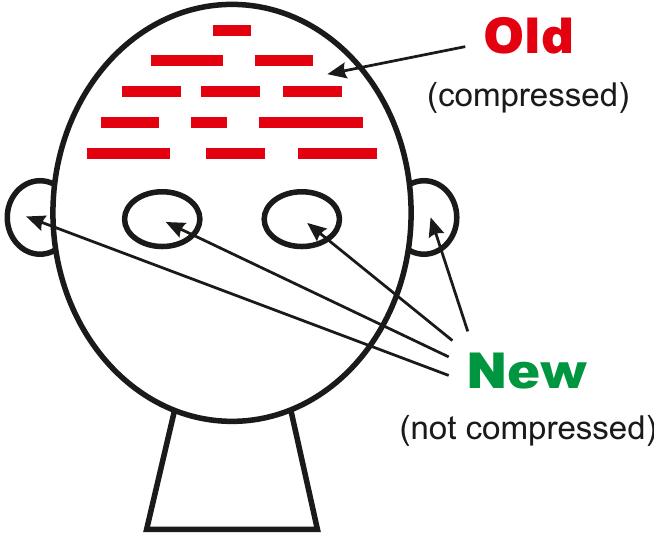
Figure A1. Schematic representation of the SPTI from an ‘input’ perspective. Reproduced, with permission, from Figure 1 in